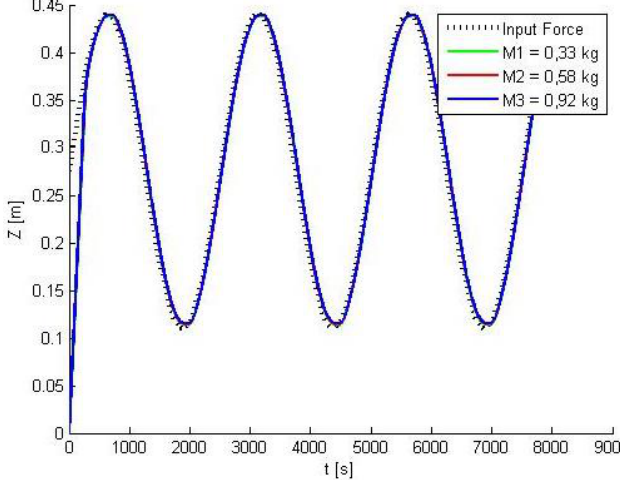
Fig. 9. Anti-swing 5DOF PI regulator Z -axis position simulation